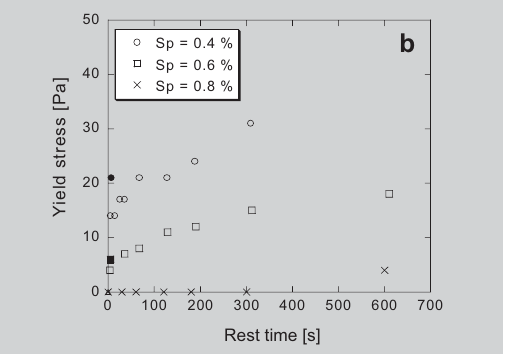
Figure 2: Measurement of the structuration of grout for different super- plasticizers concentra- tion. f = 50 %.